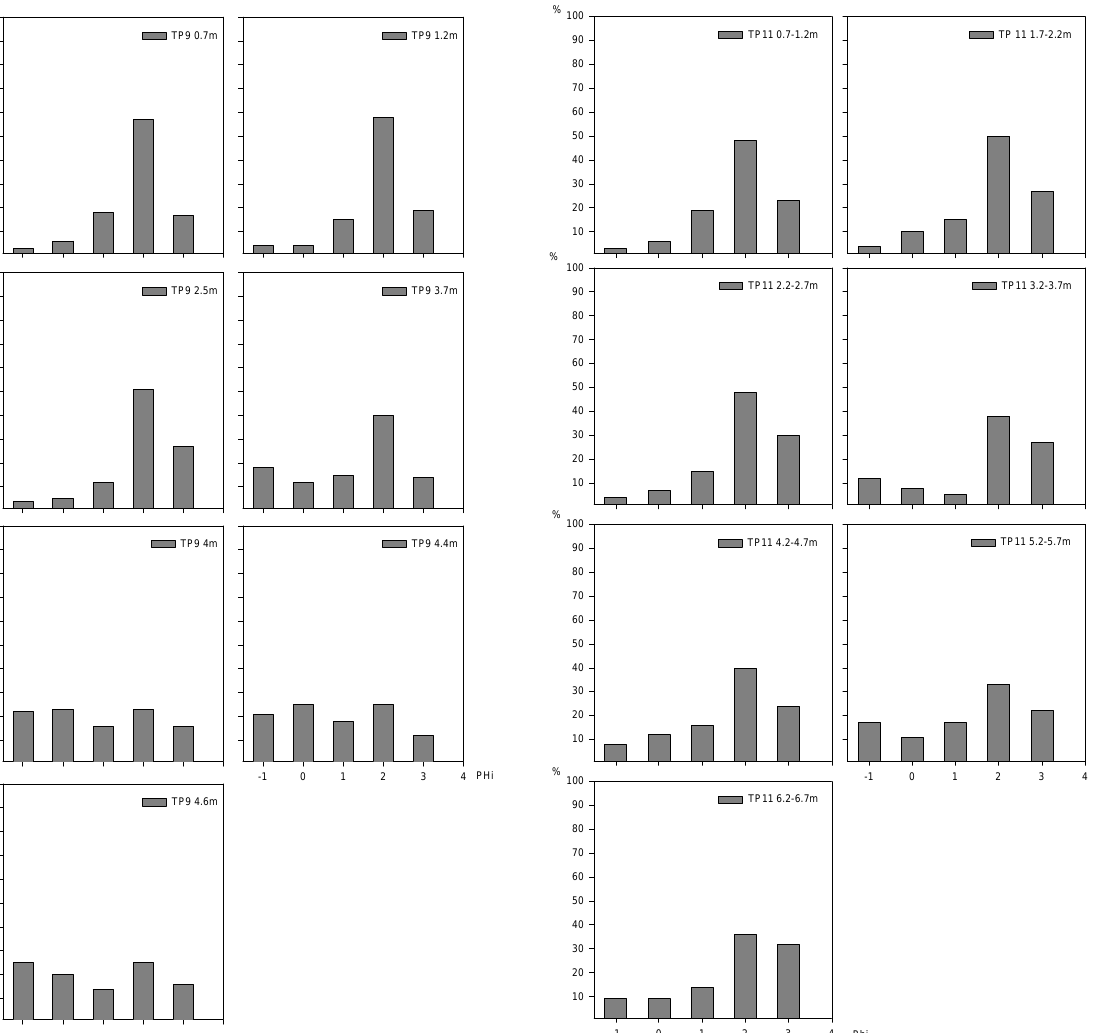
Figure 6. Distribution of five sand fractions of sample taken from the red clayey deposit overlying the diabase saprolite